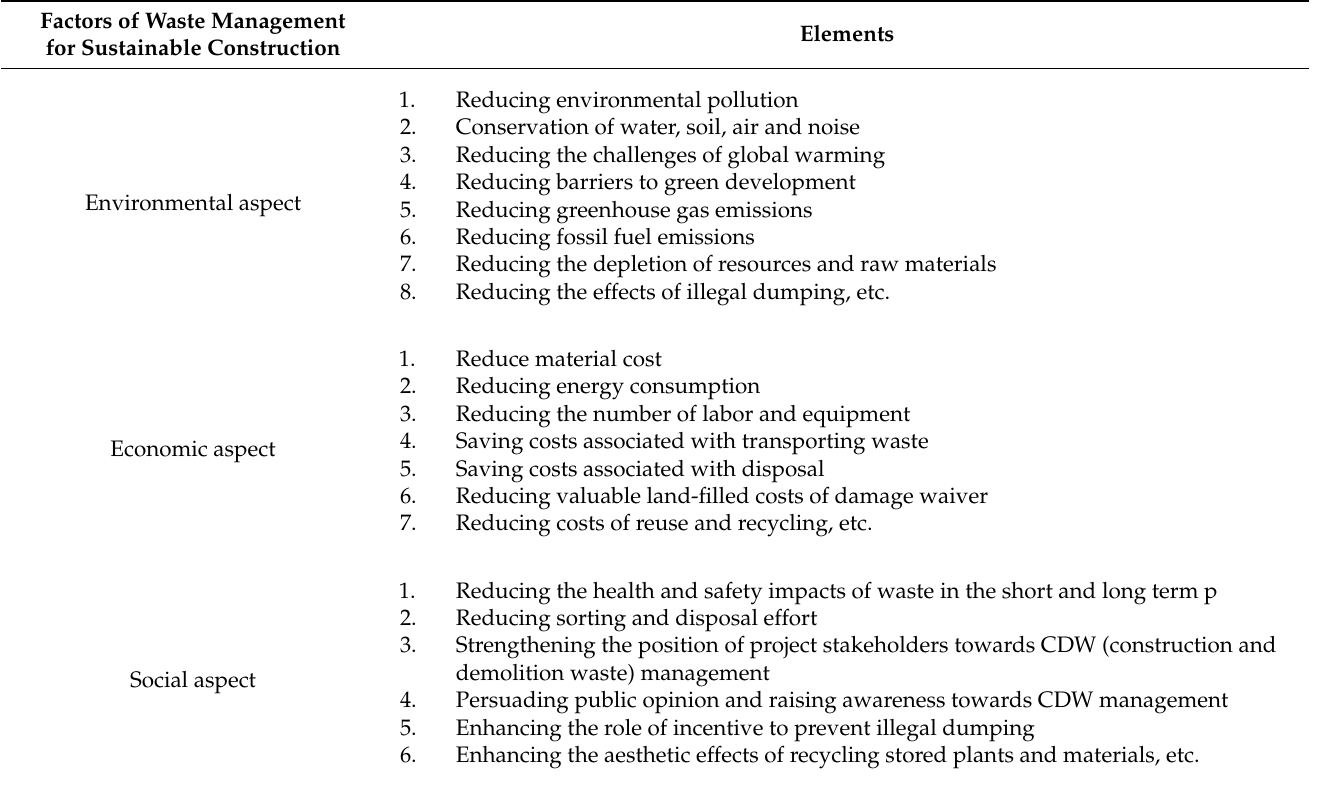
Table 1. Elements of waste management for sustainable